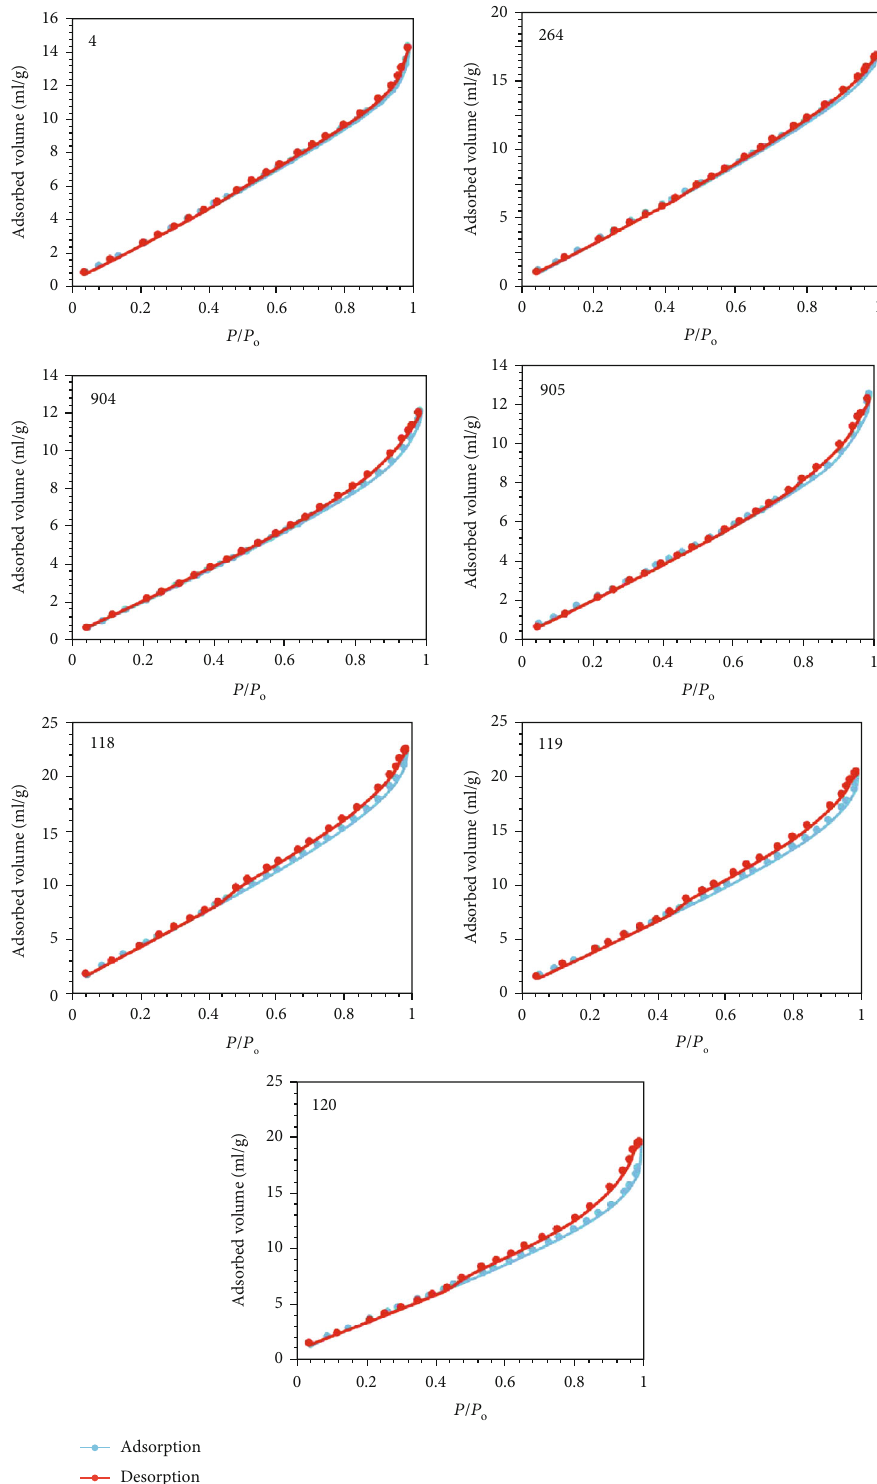
Figure 3: N -LPAI hysteresis loops for the seven tight 2